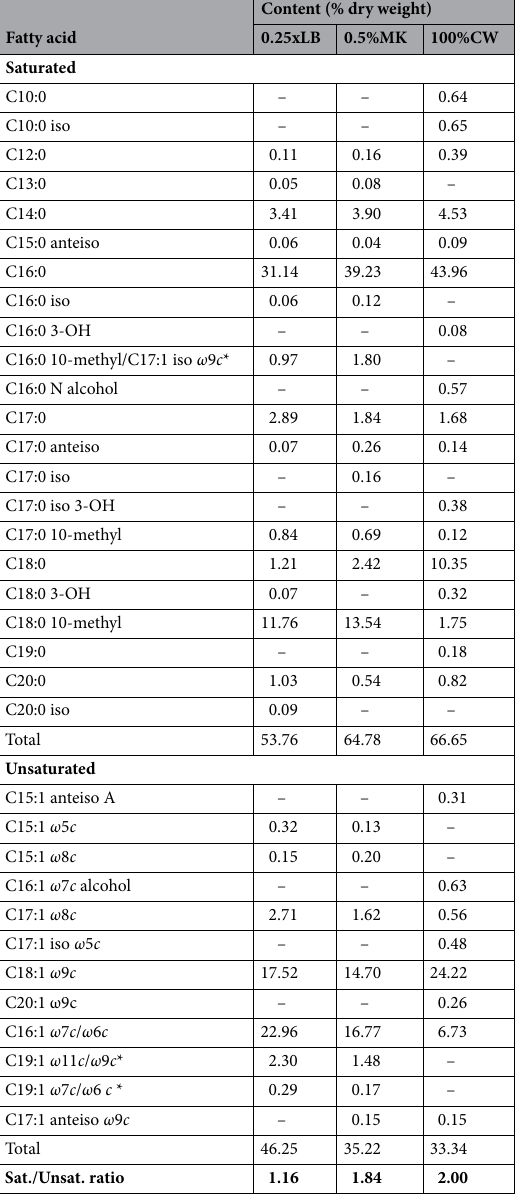
acid end; ω : methyl end of fatty acid; iso/anteiso: branched fatty acids; c : cis configuration of the double